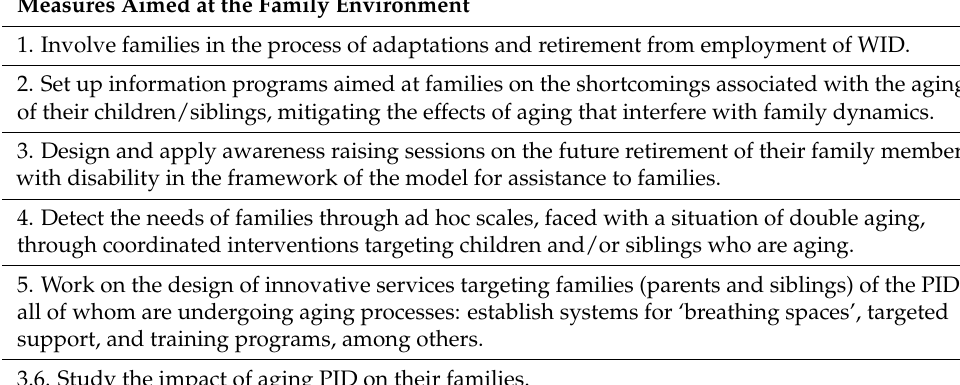
Table 8. Measures for line of action 3: the